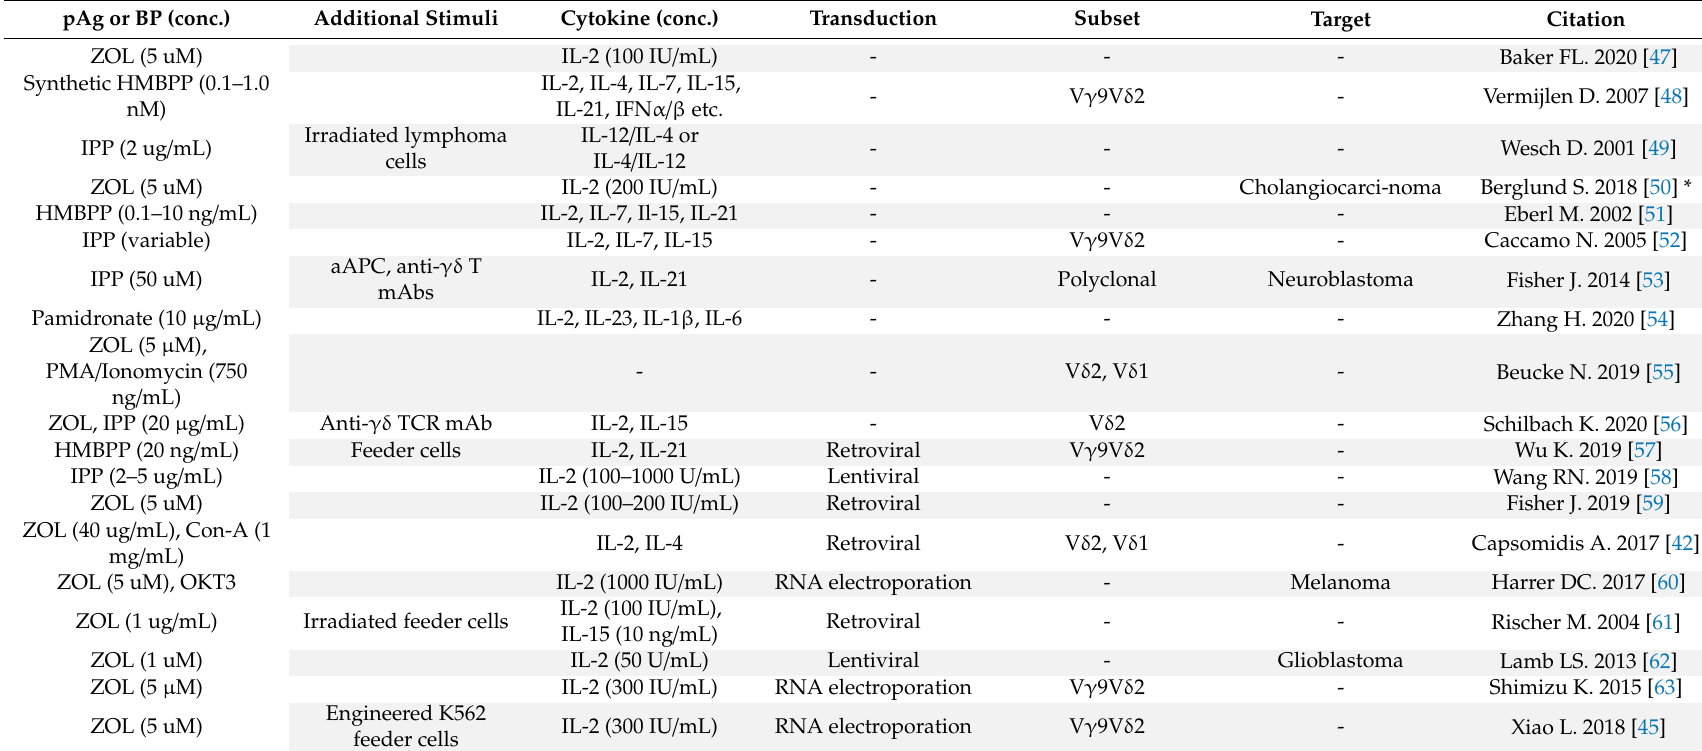
Table 1. In vitro studies using phosphoantigens or bisphosphonates for γδ T cells expansion. pAg or BP